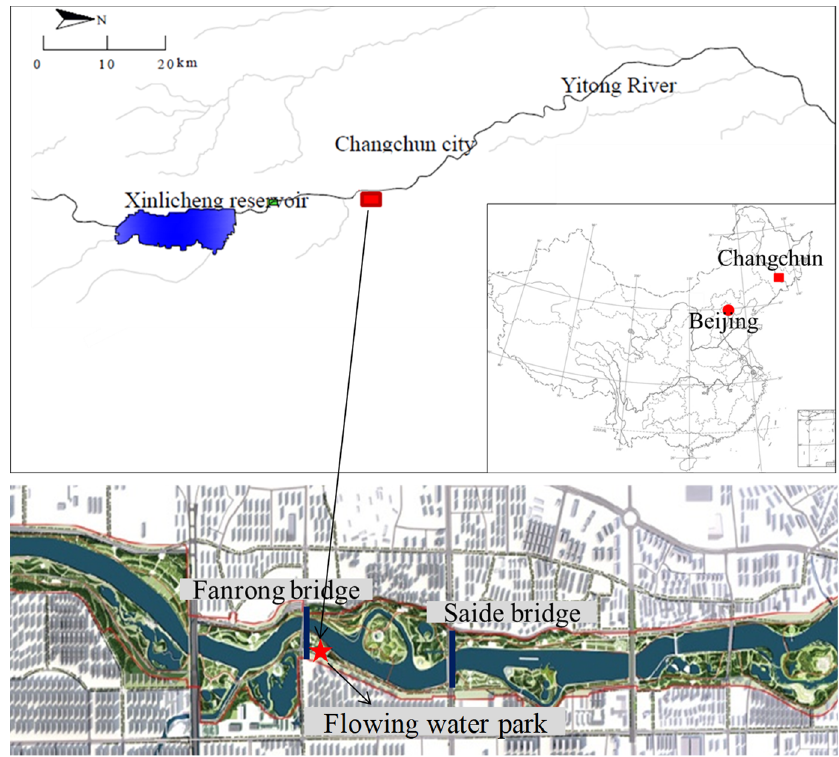
Figure 1. Location and overview of the study area.